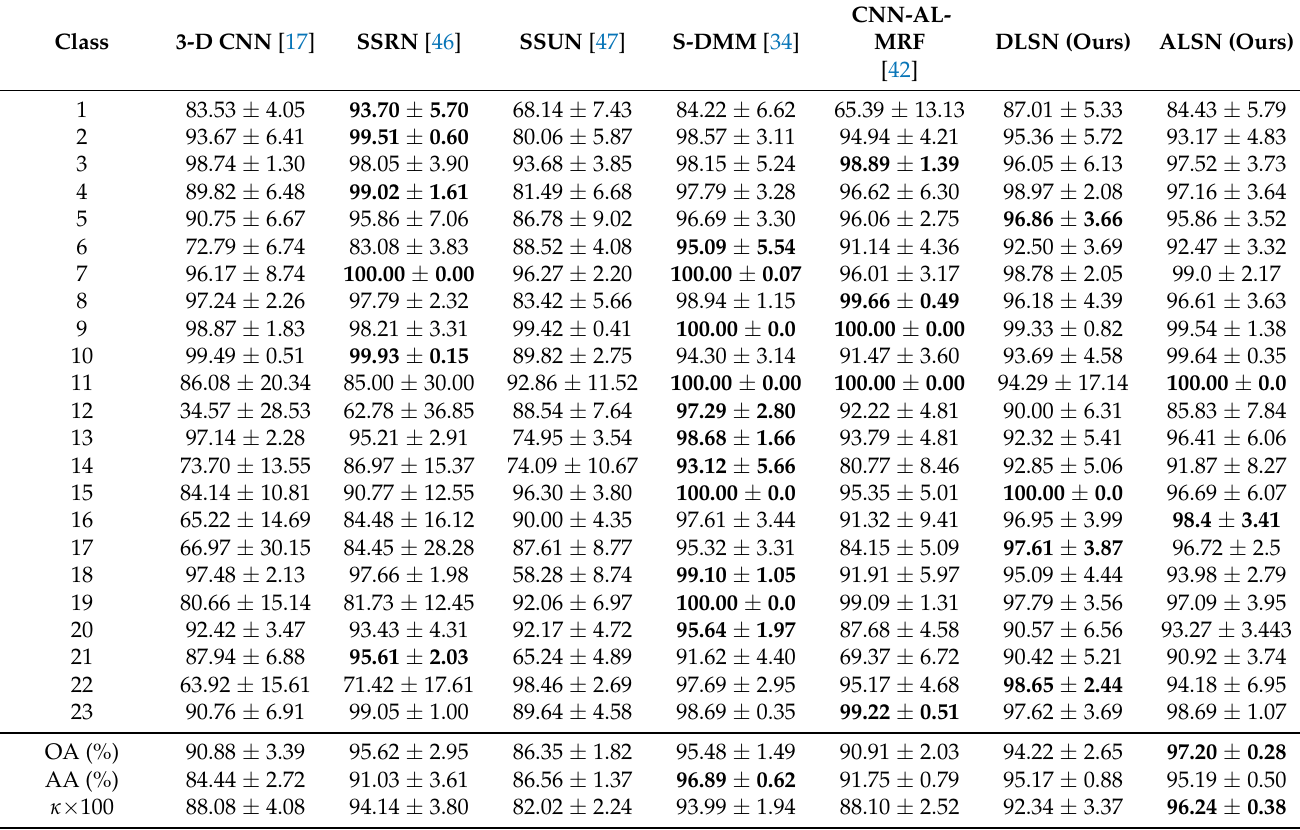
Table 7. Classification accuracy (%) for YRD dataset (9 iterations for AL methods and 19 labeled samples per class for other